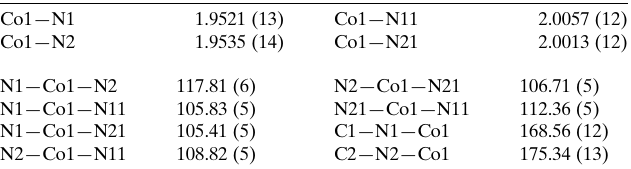
Table 4 Hydrogen-bond geometry (A˚ , (cid:4) ) for form